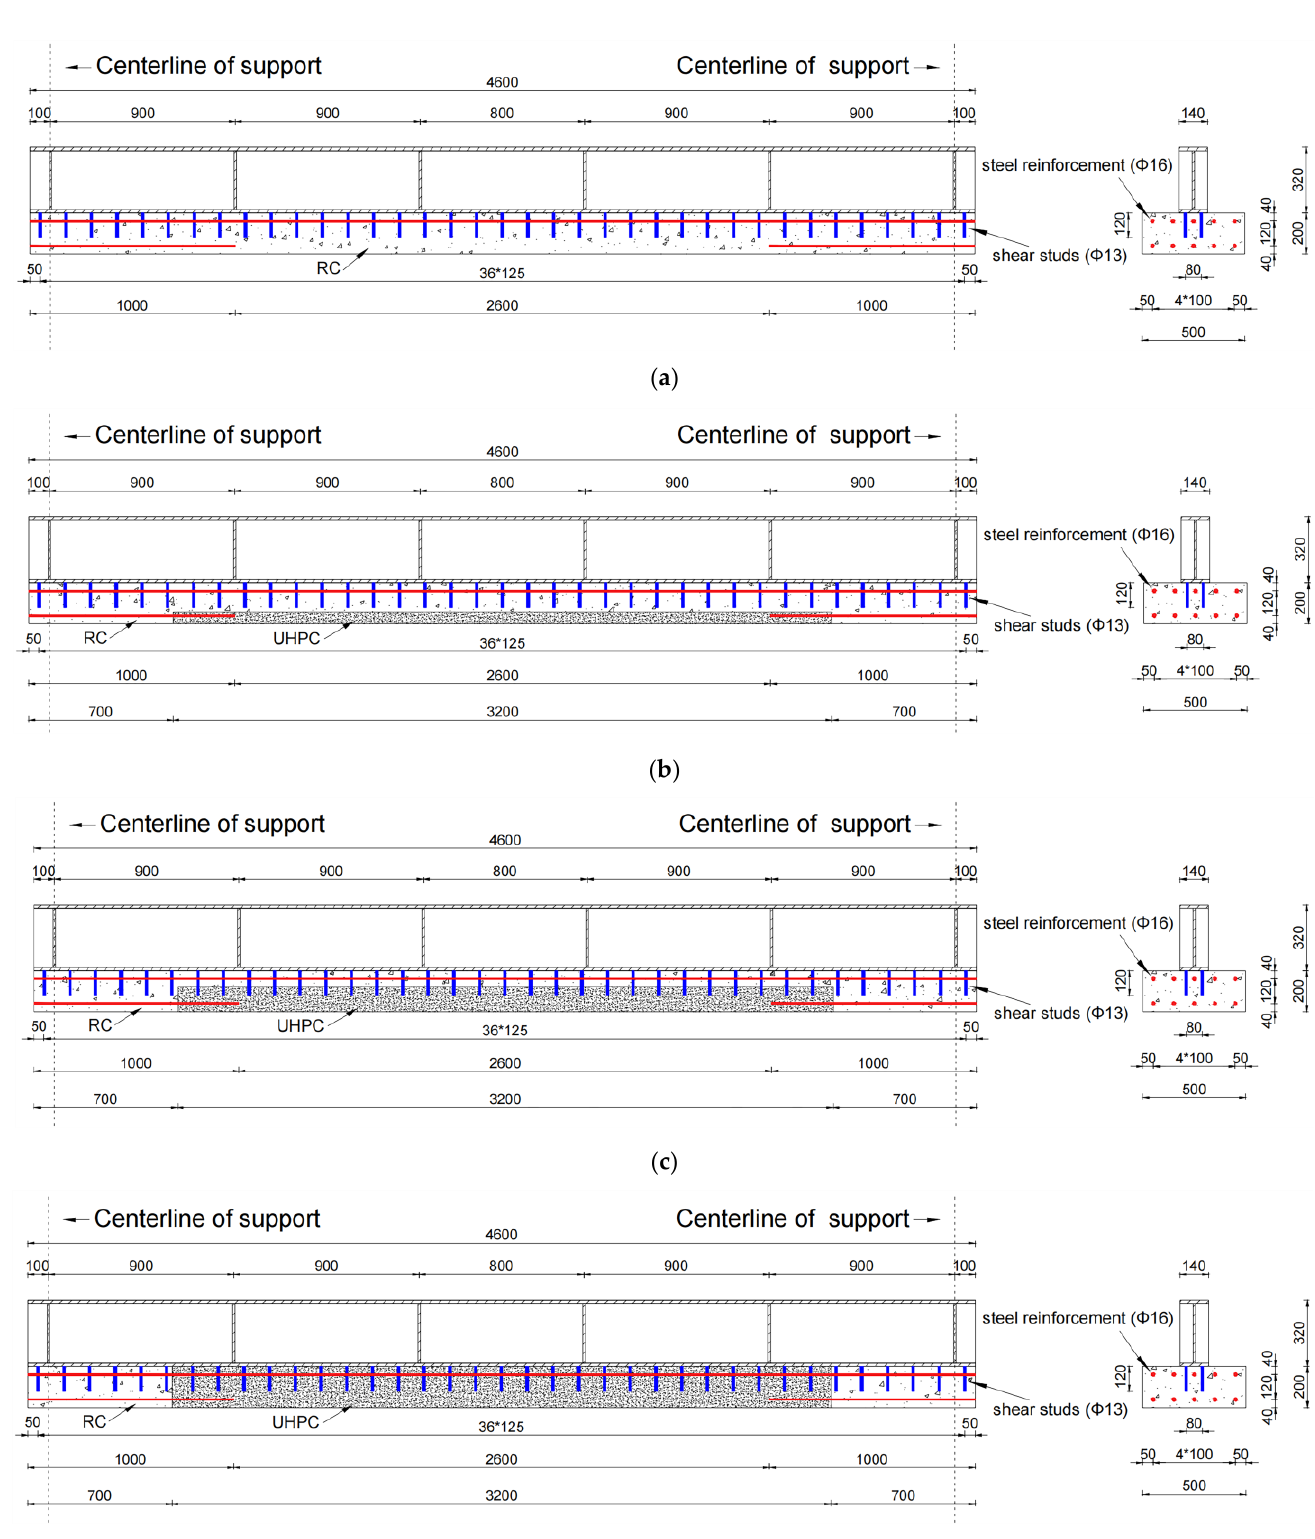
Figure 3. Detailed dimensions of the specimens (unit: mm): ( a ) detailed dimensions of specimen A; ( b ) detailed dimensions of specimen B; ( c ) detailed dimensions of specimen C; ( d ) detailed dimensions of specimen D.